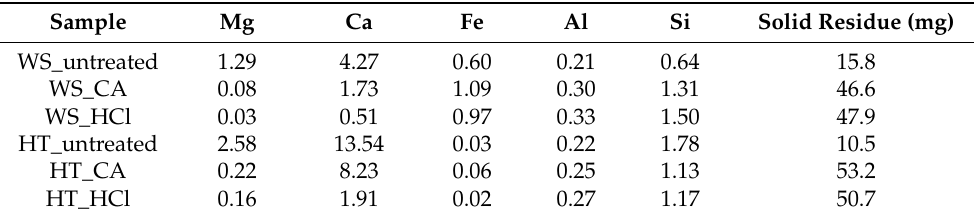
Table 3. Content of selected elements in